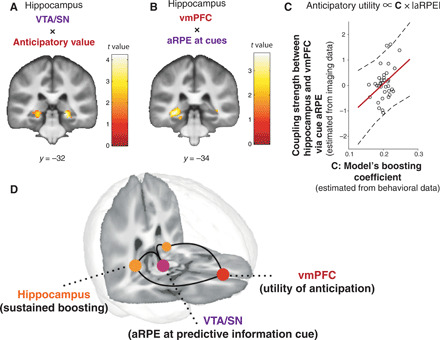
Functional connectivity analysis suggestive of a neural network associated with our model’s anticipation utility computation.(A) Functional coupling between the VTA/SN and the hippocampus is positively modulated by the model’s anticipation utility signal [P < 0.05, FWE small volume correction (46)]. PPI regressor: BOLD signal in VTA/SN modulated by model’s anticipation utility signal. (B) Functional coupling between the vmPFC and the hippocampus is positively modulated by the model’s aRPE signal [P < 0.05 FWE small volume correction (46)]. PPI regressor: BOLD signal in vmPFC modulated by the model’s aRPE signal. (C) The functional coupling strength between the vmPFC and the hippocampus mediated by the model’s prediction error signal is positively correlated with the model’s boosting coefficient parameter estimated by the behavior of participants (r = 0.37, P < 0.05). (D) Three distinctive regions contributed to construct the anticipation utility, in a manner that is predicted by our computational model. The three-dimensional brain image was constructed by the mean T1 brain images, which were cut at y = 34 and z = 15.